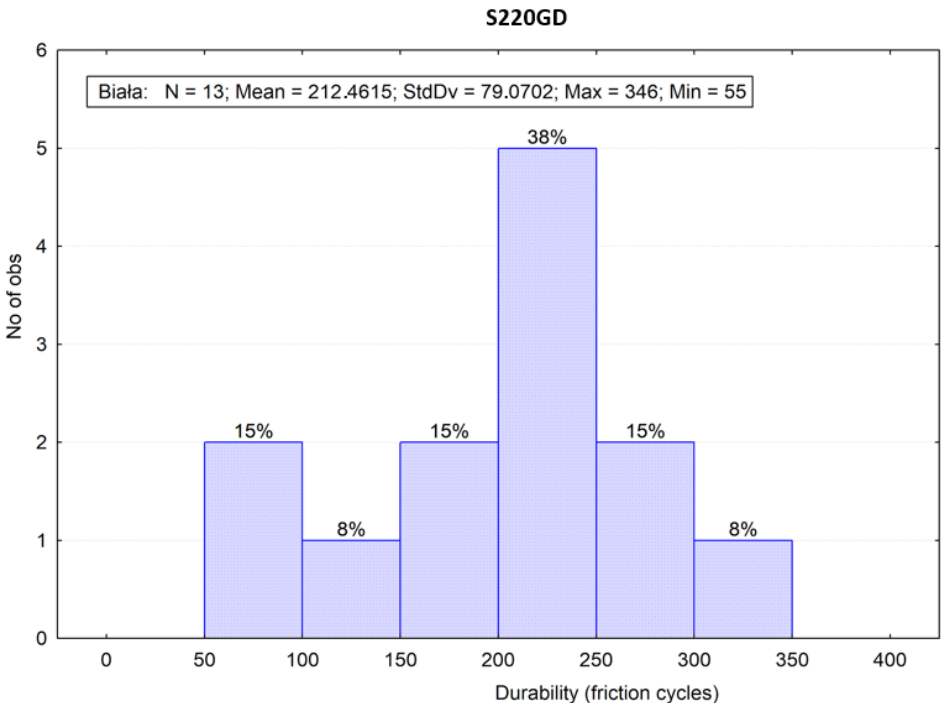
Figure 9. Frequencies of the sliding friction test results of the “white” (S220GD) coating.